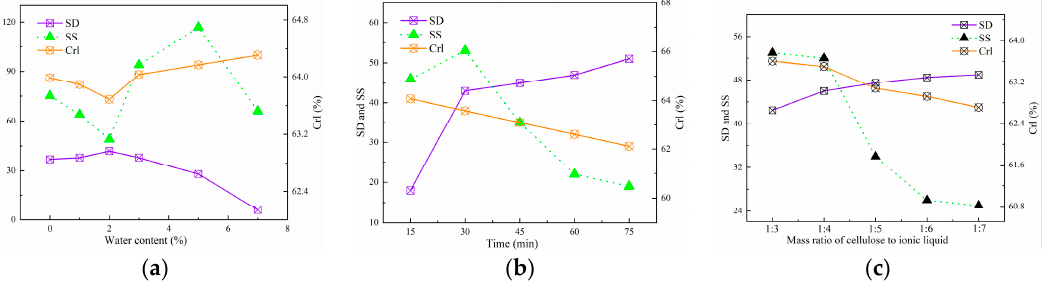
Figure 3. E ff ects of swelling parameters on the properties of the MCC in [AMIm][Cl]. ( a ) E ff ect of Figure 3. Effects of swelling parameters on the properties of the MCC in [AMIm][Cl]. ( a ) Effect of water content. ( b ) E ff ect of time. ( c ) E ff ect of mass ratio of cellulose to ionic liquid. water content. ( b ) Effect of time. ( c ) Effect of mass ratio of cellulose to ionic